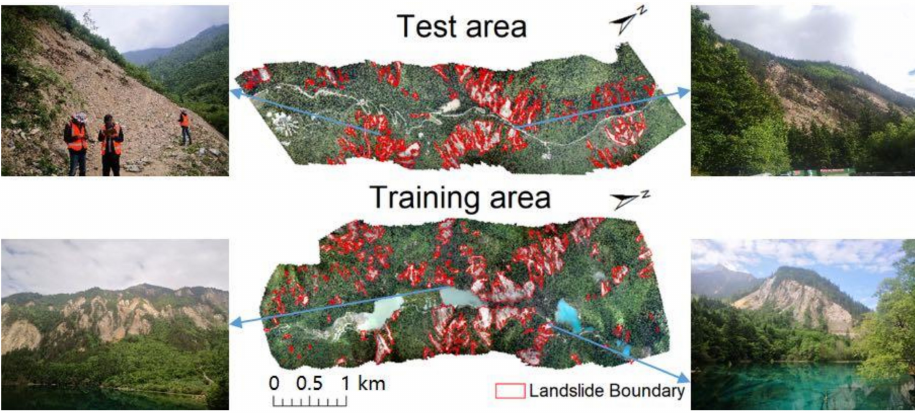
Figure 9. Parts of field